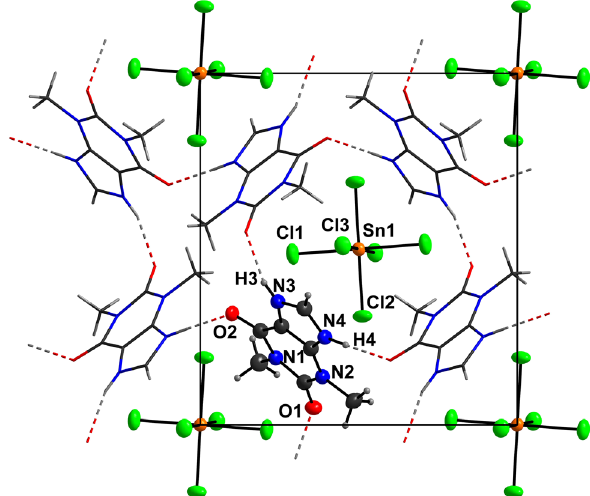
Table 1 contains crystallographic data and Table 2 contains the list of the atoms including atomic coordinates and displacement parameters.